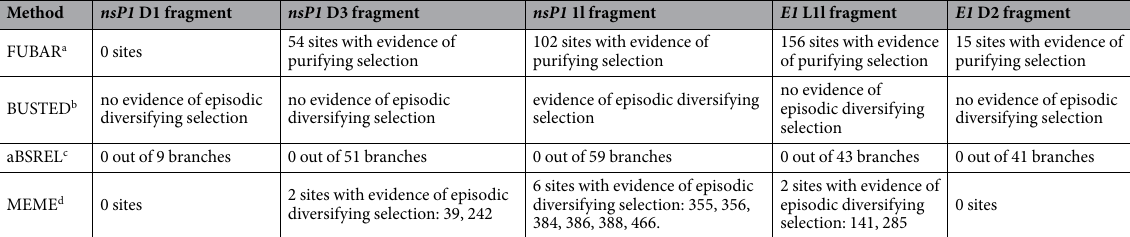
Table 1. Evidence of selection pressure among codon sites within the recombinant nsP1 and E1 genes. a Fast unconstrained Bayesian approximation of pervasive selection (PP > 0.90); b Bayesian unconstrained test for episodic diversifying selection (LRT p ≤ 0.05); c Branch-specific episodic diversifying (adaptive) selection